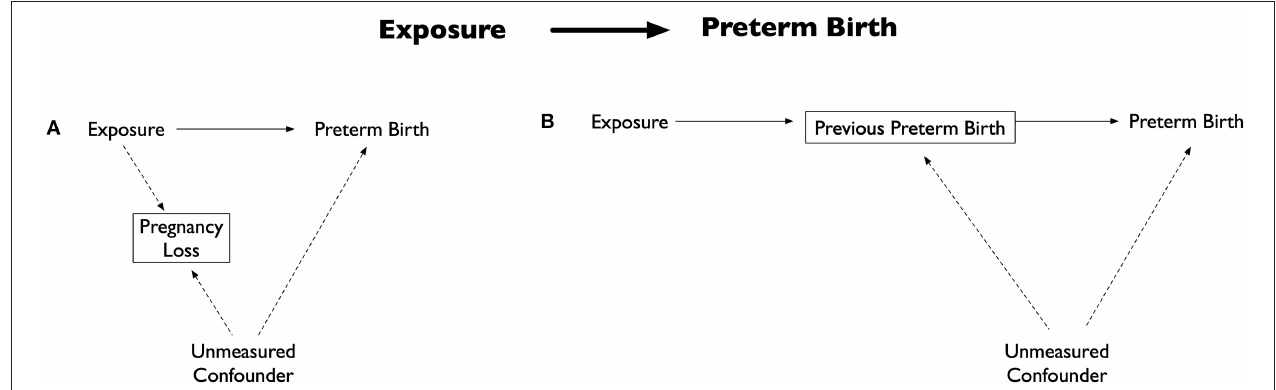
FIGURE 2 | Directed acyclic graph illustrating selection bias examples. Adapted from: (19). (A) Potential bias by inclusion of only live births. The exposure is associated with outcome (preterm birth) and pregnancy loss, while the outcome and pregnancy loss are associated with an unmeasured confounder. Including only live births (essentially an adjustment of pregnancy loss) results in creation of a non-causal pathway between the exposure, unmeasured confounder and preterm birth. (B) Potential bias by adjusting for an intermediate variable. Commonly adjusted intermediate variable for the exposure and preterm birth is previous preterm birth. Adjustment of previous preterm birth results in creation of a non-causal pathway between the exposure, intermediate variable, unmeasured confounder and preterm